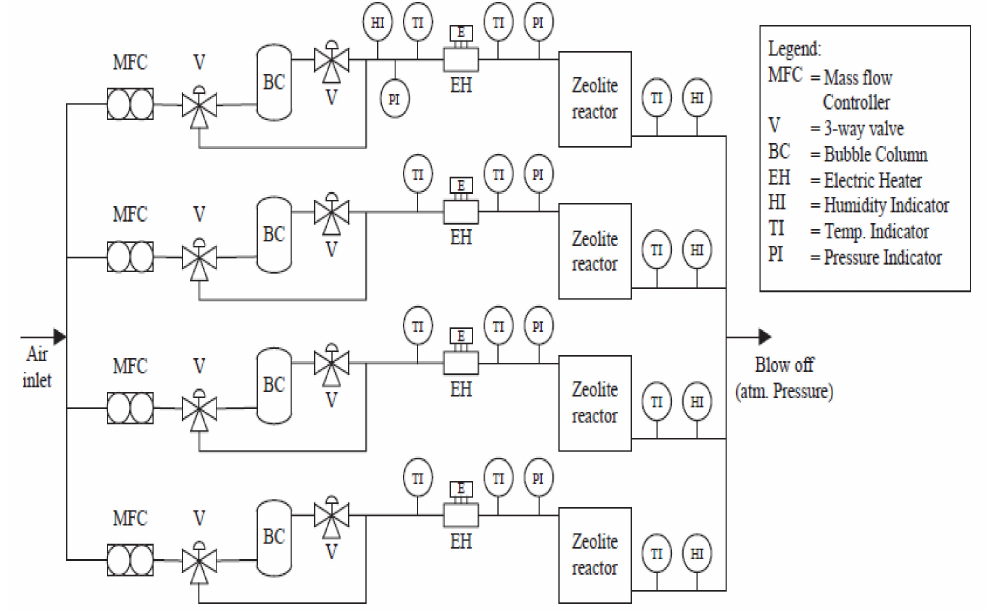
Figure 20. Schematic layout of the sorption TES system